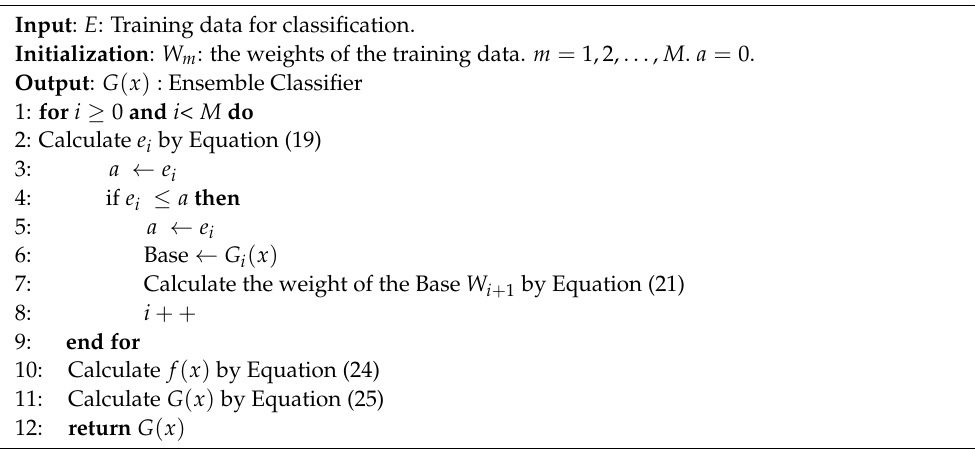
Algorithm 1 Integration Algorithm to Implement Ensemble